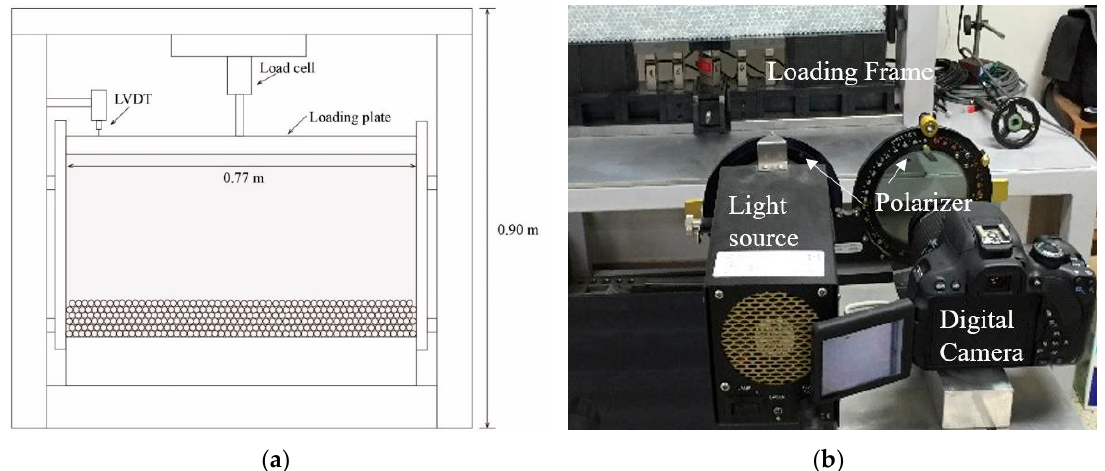
Figure 3. Testing apparatus: (a) loading frame; (b) reflective polariscope.